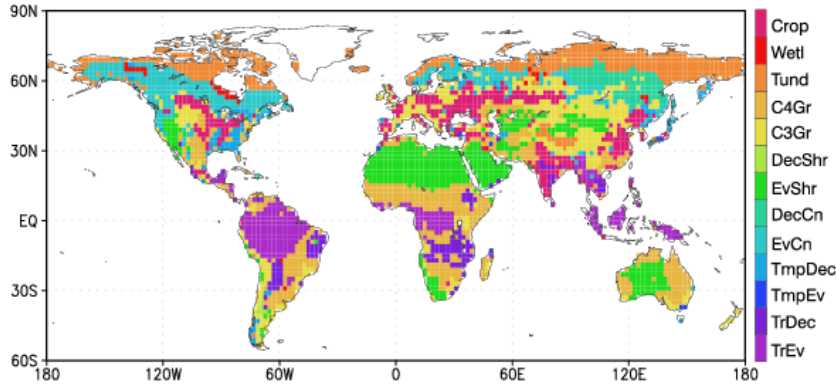
Fig. 1. Distribution of the dominant CCDAS Plant Functional Type (PFT) per grid cell, PFT labels are given in Table 1, taken from Rayner